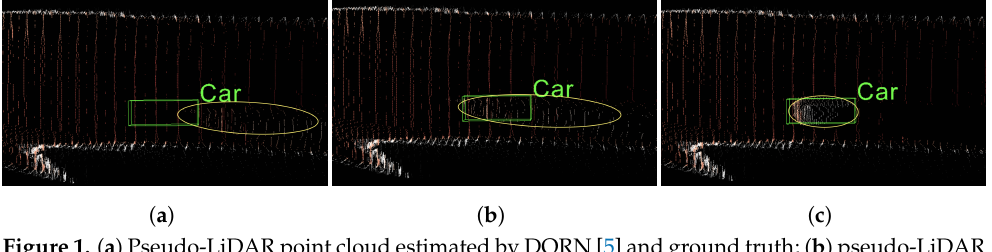
Figure 1. ( a ) Pseudo-LiDAR point cloud estimated by DORN [5] and ground truth; ( b ) pseudo-LiDAR point cloud estimated by our proposed depth refinement; ( c ) pseudo-LiDAR point cloud estimated by our proposed depth distribution adjustment. (Yellow ellipses indicate the object’s point